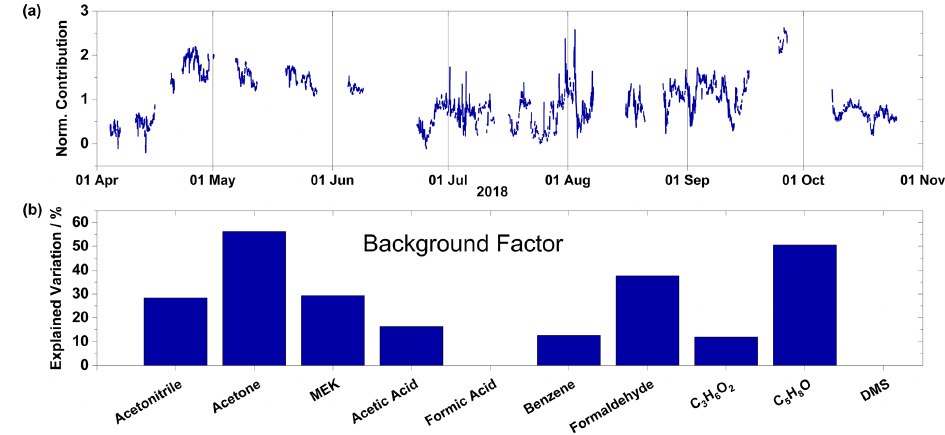
Figure 8. (a) Time series of normalized contributions and (b) species profile for the background factor. Factor contributions are normalized to give a mean contribution of unity.